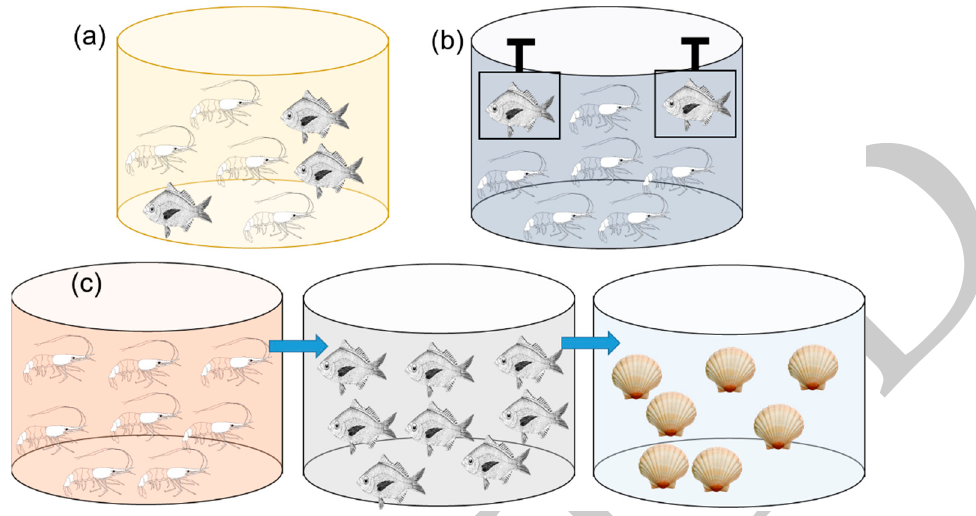
Figure 5. Types of polyculture systems: ( a ) direct polyculture, ( b ) pond-cum-cage polyculture, and ( c ) sequential polyculture. Compatible species other than those shown in the figure can be cultured.